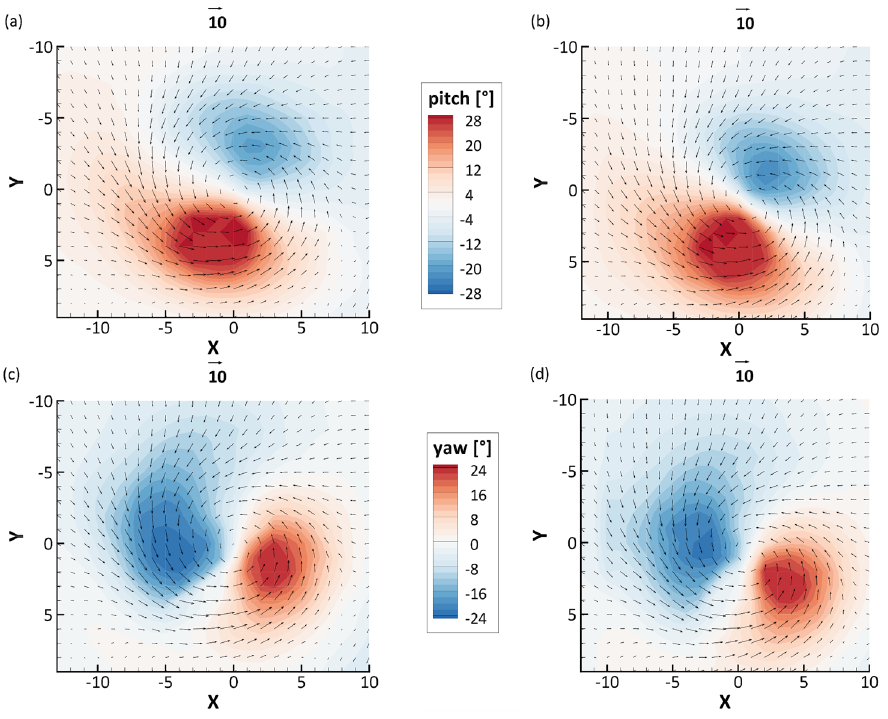
Figure 9. 5-hole probe pitch ( a , b ) and yaw ( c , d ) results for type C swirler with relative feeding pressure ( a , c ) 0.75 bar, ( b , d ) 0.5 bar.